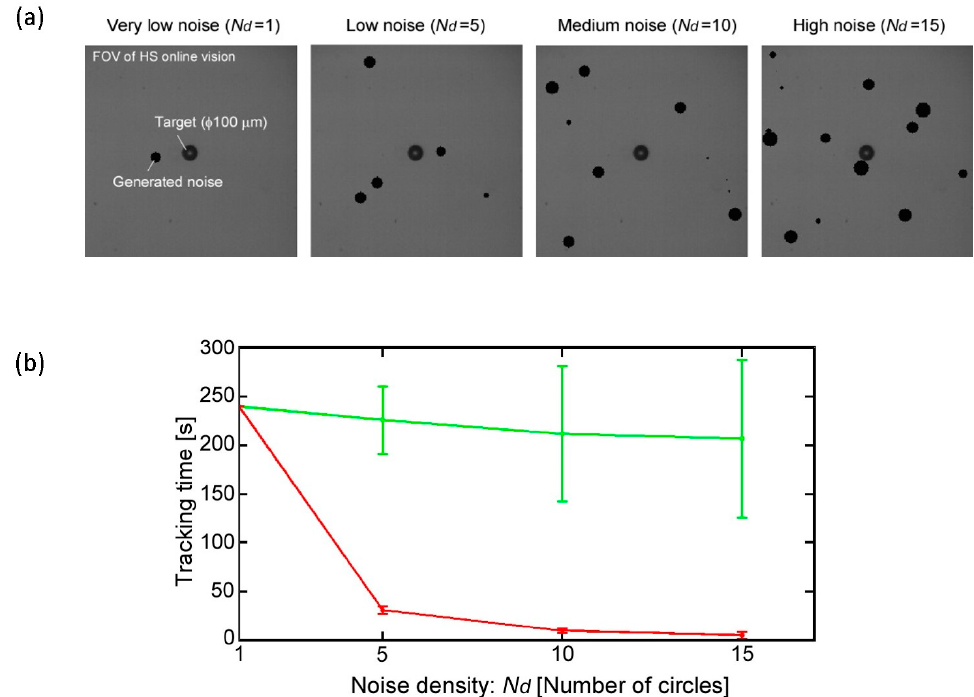
Figure 8. Robustness evaluation of target tracking in noisy environment. ( a ) Examples of four different noisy situations; ( b ) Total tracking time with typical image processing method (red) and implemented image processing method (green).